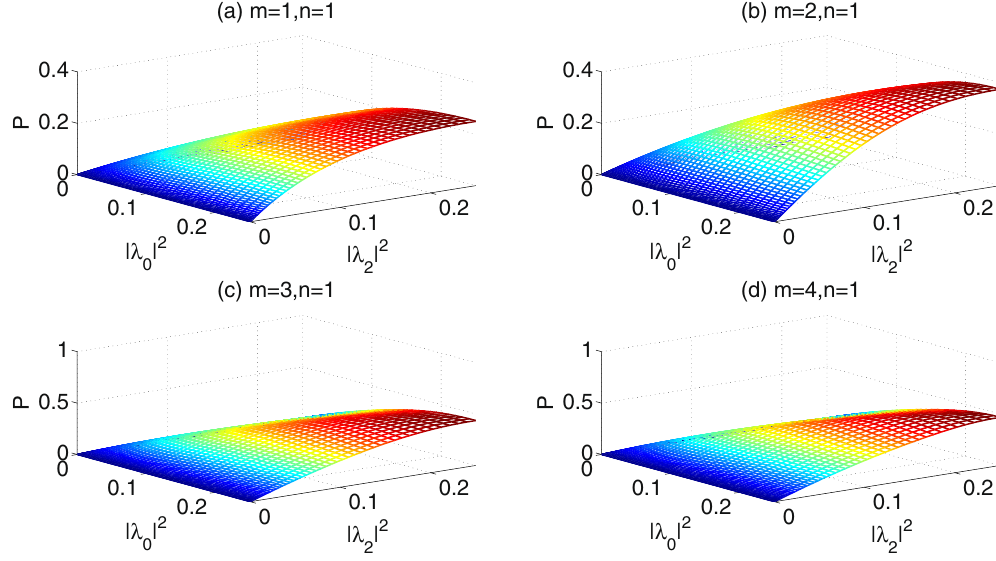
Figure 5. The success probabilities of the concentration in the second ECP vs the parameters | λ 0 | 2 and | λ 2 | 2 , when the number of Charlie’s iterations is fixed as n = 1.